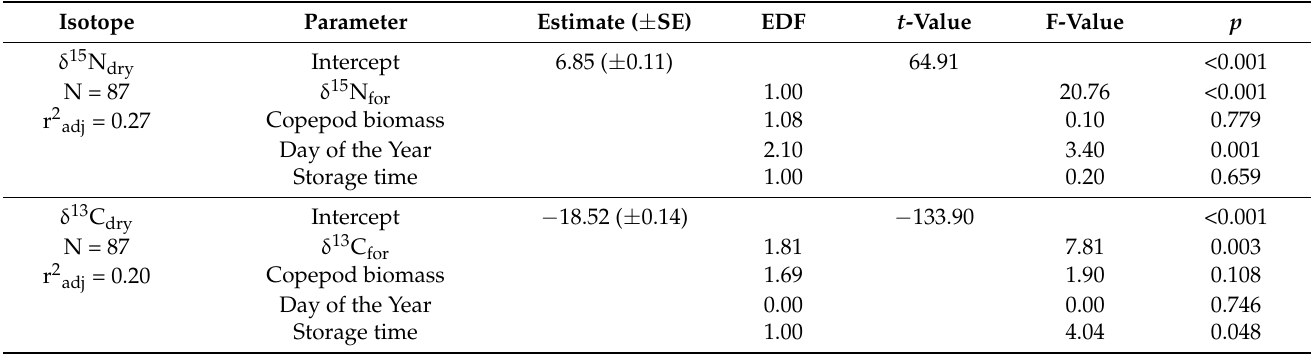
Table 2 . Results of the generalised additive models (GAMs) fi tt ed to the isotope measures. SE: stand- ard error; EDF: estimated degrees of freedom; P: signi fi cance.; N: number of data; r 2adj : adjusted determination coe ffi cient.